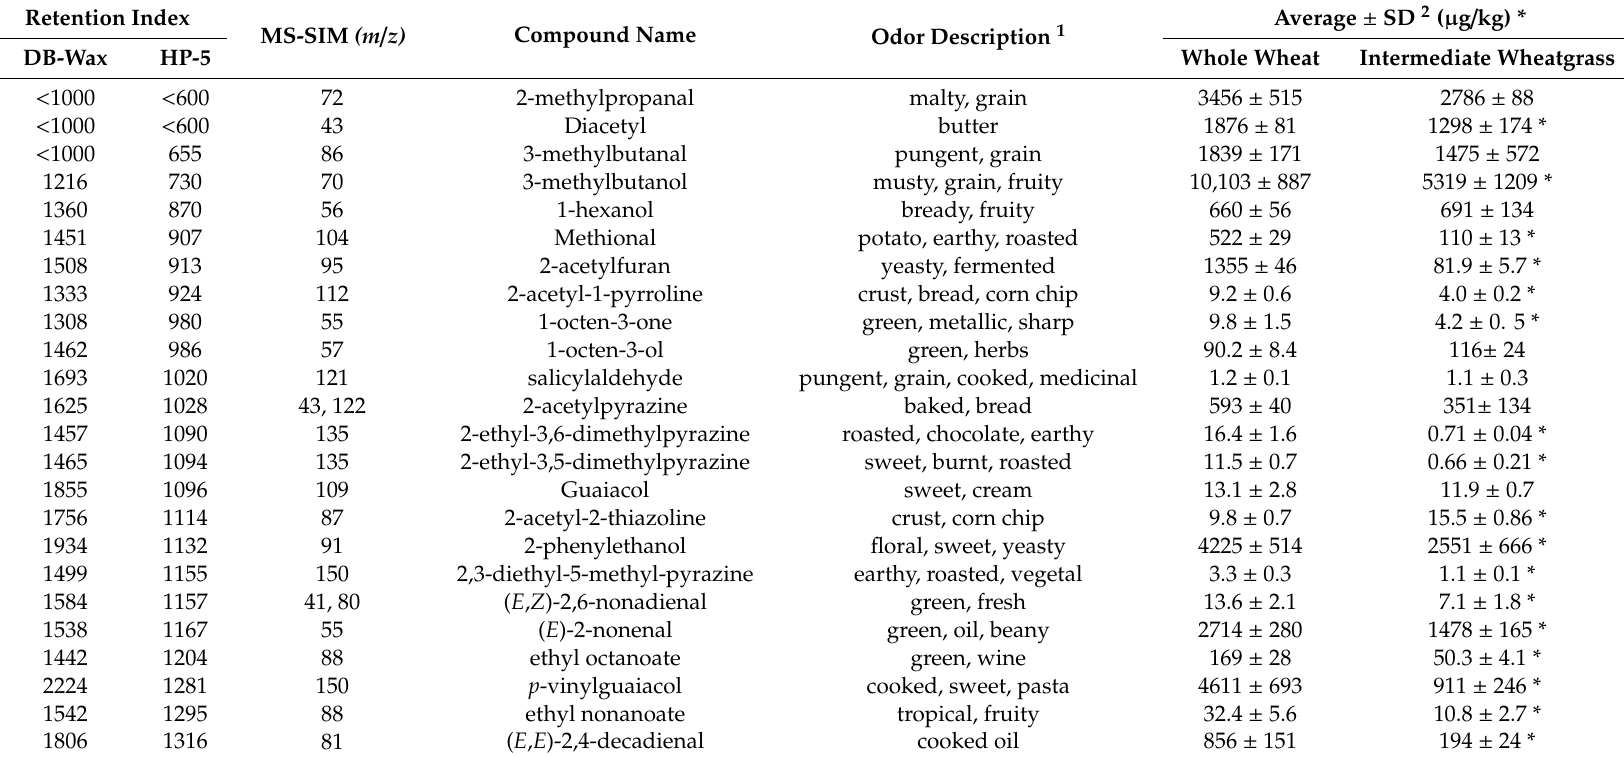
Table 1. Concentration of aroma compounds identified in whole wheat and intermediate wheatgrass bread